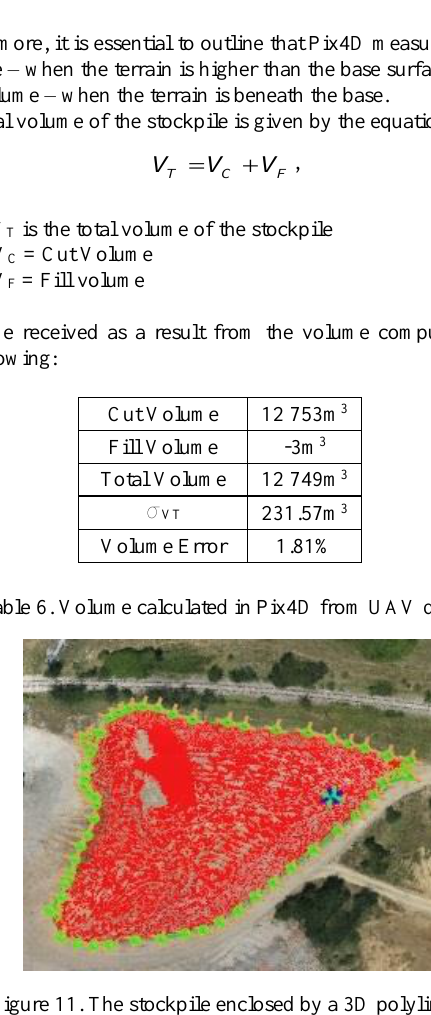
Figure 11. The stockpile enclosed by a 3D polyline